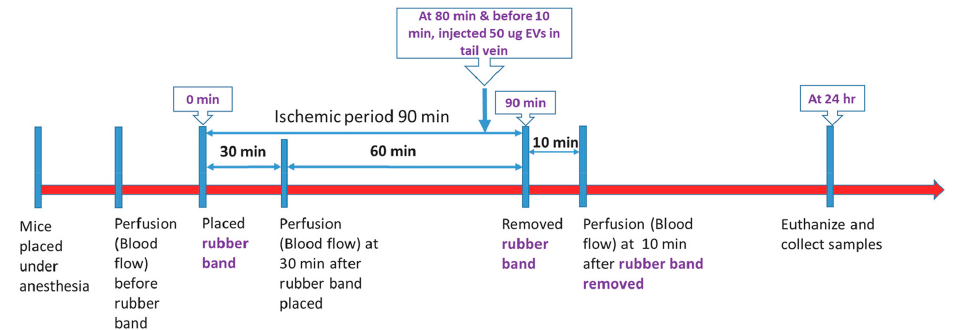
Figure 1. Experimental design. Hindlimb ischemia was induced for 90 min using an orthodontic rubber band. Blood flow was measured prior to band placement, after band placement, and after band removal using Laser Doppler imaging. EVs were delivered via a tail vein 10 min prior to reperfusion, and tissue was collected 24 h after reperfusion.